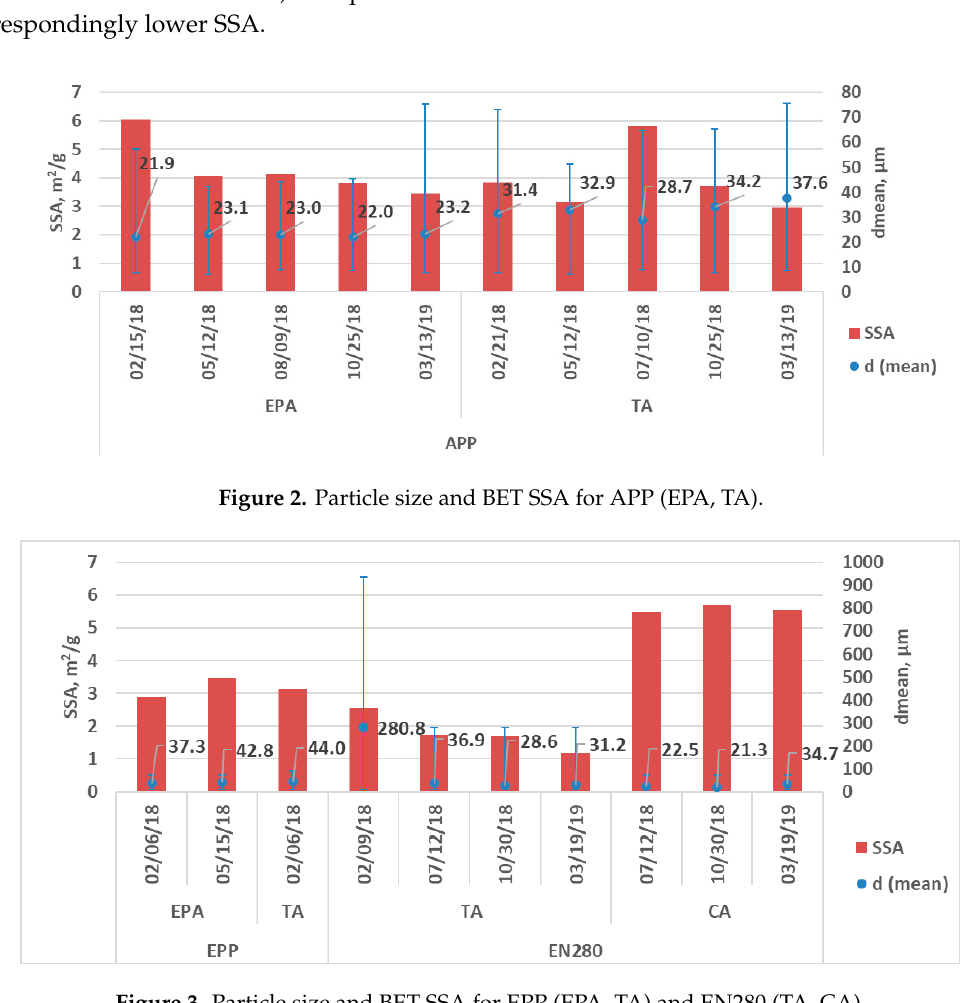
Figure 3. Particle size and BET SSA for EPP (EPA, TA) and EN280 (TA, CA).